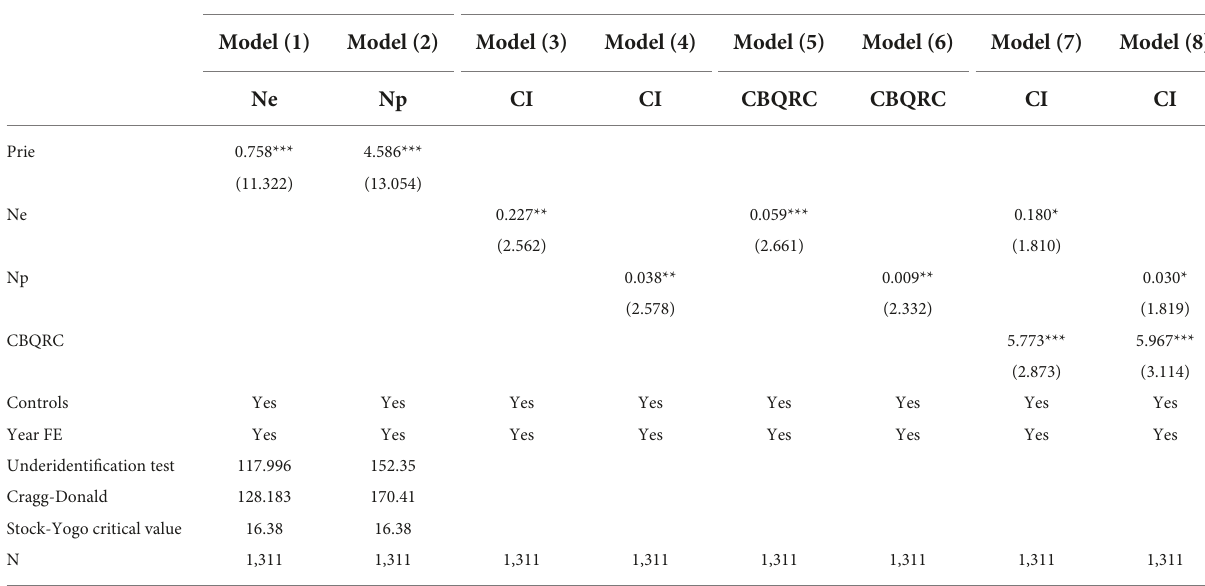
TABLE 4 Robustness checks for the endogenous